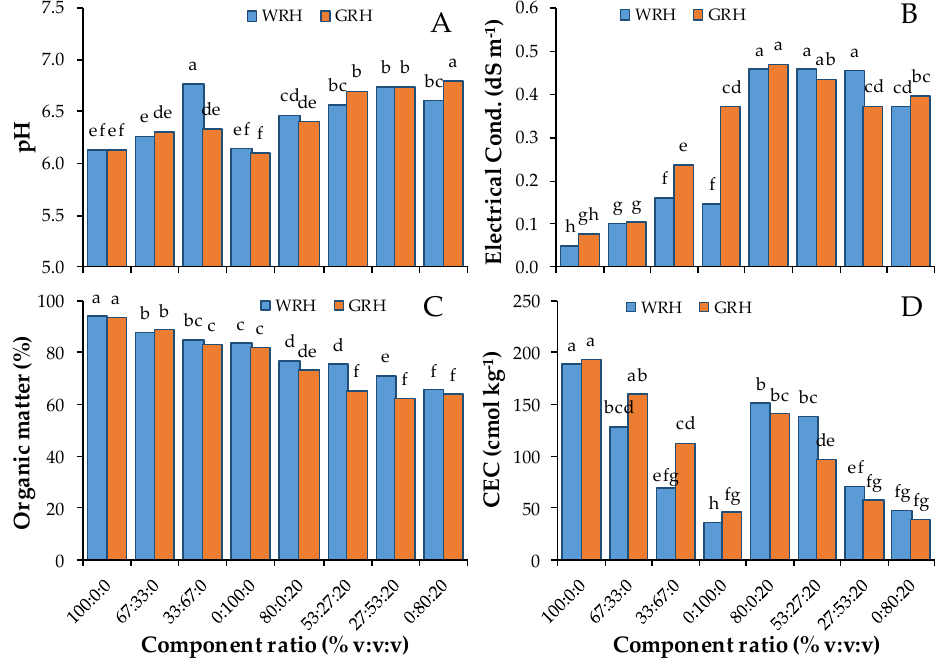
Figure 2. Interaction e ff ects of the component ratio (P:RH:ADR % v:v:v) and rice hulls (RH) grinding (whole rice hulls and ground rice hulls, WRH and GRH) on: ( A ) pH; ( B ) electrical conductivity; ( C ) organic matter content; and ( D ) cation exchange capacity (CEC) of the evaluated substrates. Significant di ff erences among treatments are indicated by di ff erent letters according to Tukey’s HSD test ( p < 0.05). P: peat; ADR: anaerobic digestion